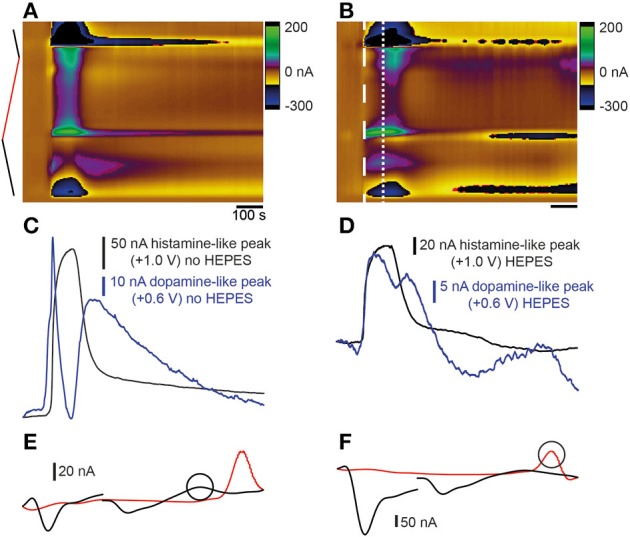
Comparison of stimulation with high K+ aCSF with- and without HEPES buffer. (A) Color plot showing changes in current evoked by stimulation with high K+ aCSF without HEPES. The same color plot is shown in Figure 2A. (B) Color plot showing changes in current evoked by stimulation with high K+ aCSF containing HEPES buffer. Thick dashed white line shows the time point and potential at which the first analyte was maximal. Thin dashed white line shows the time point at which the second analyte was observed. Current vs. time plots for responses obtained in high K+ aCSF without HEPES (C) (same traces as shown in Figures 2C,E for comparison) compared to aCSF containing HEPES buffer (D). Blue lines show dopamine-like current and black lines show histamine-like current. (E) Voltammogram extracted at time point indicated by thick dashed white line in (B). Circle corresponds to blue line in (D). (F) Voltammogram extracted at time point indicated by thin white line in (B). Circle corresponds to black line in (D).